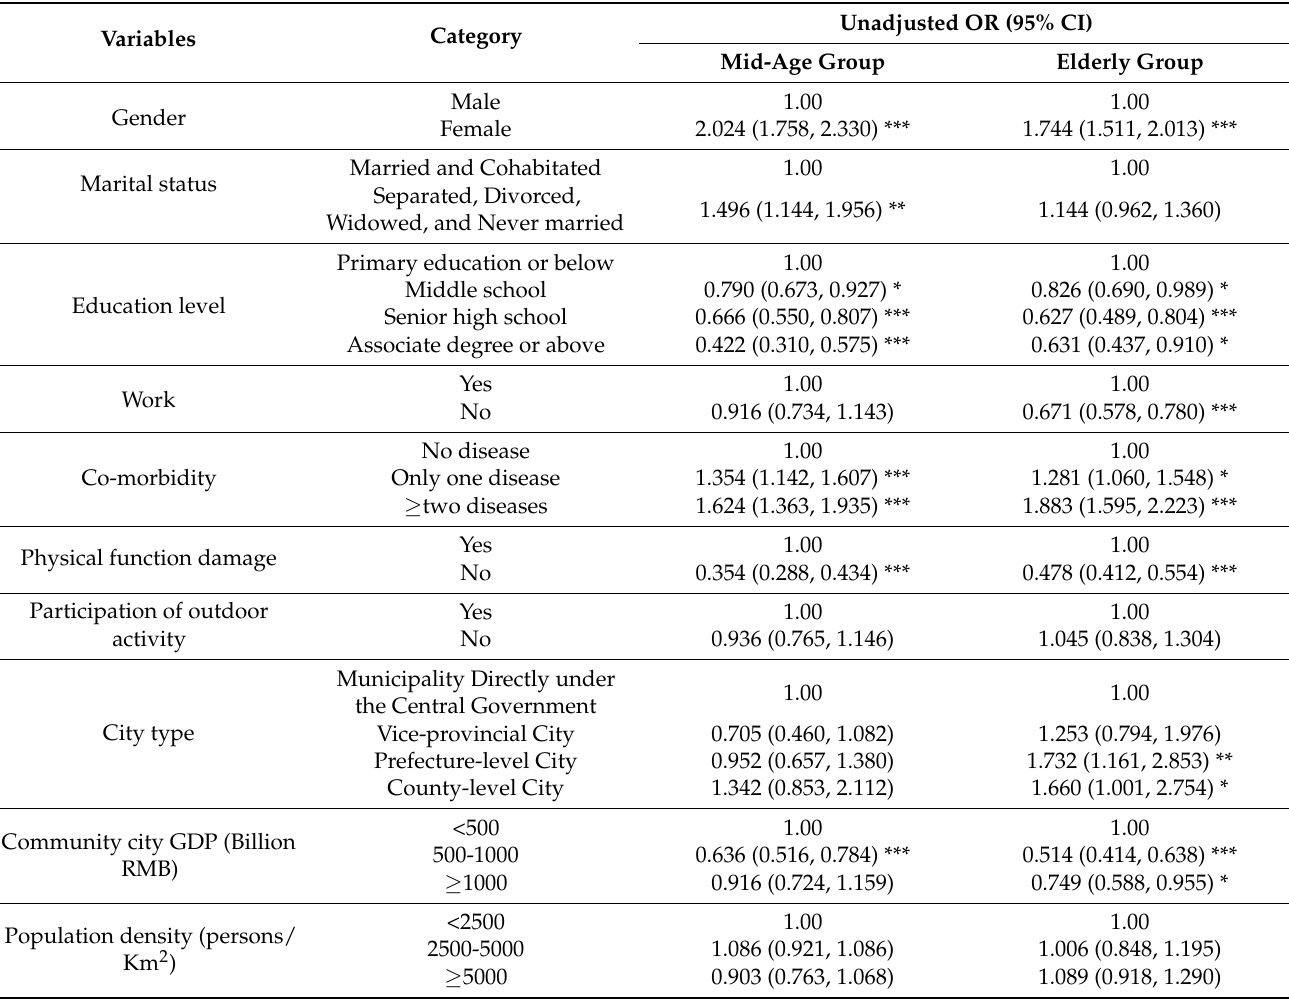
Table 3. ORs (95% CI) of depressive symptoms in relation to individual and environmental factors by age group ( N = 7396).